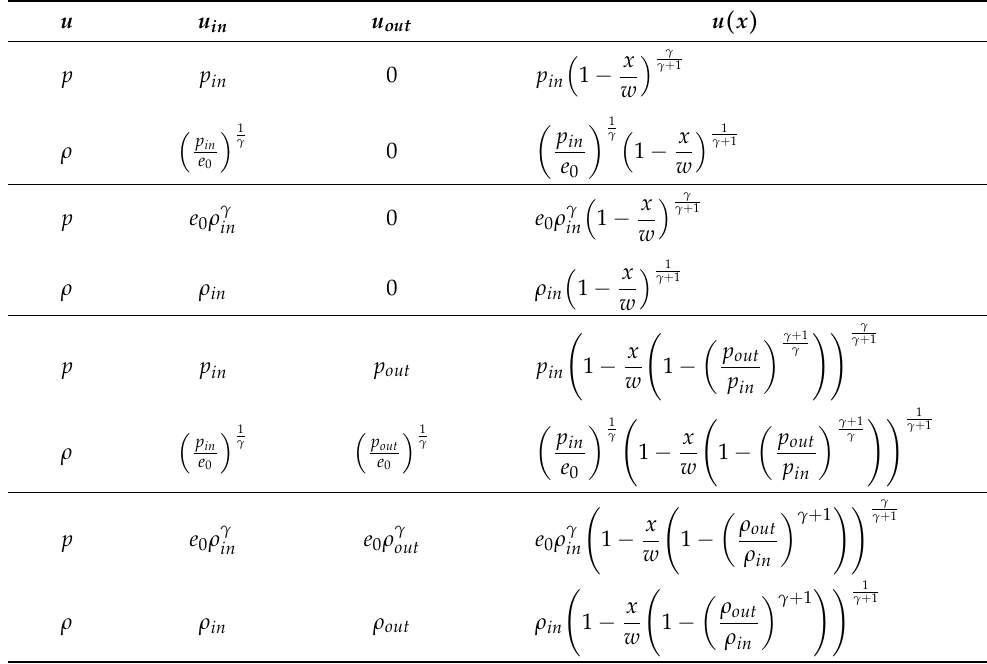
Table 3. Overview of stationary solutions to Dirichlet